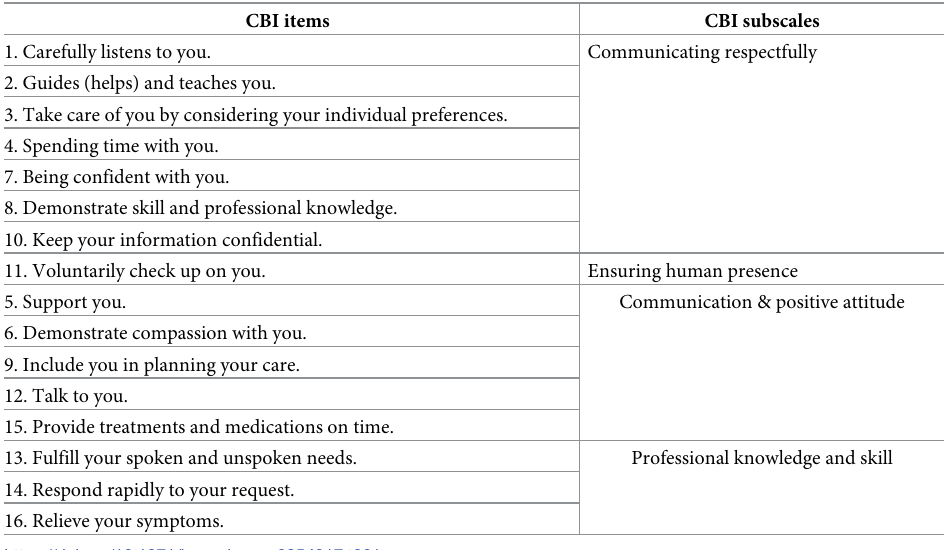
Table 1. Subscales of the 16-item